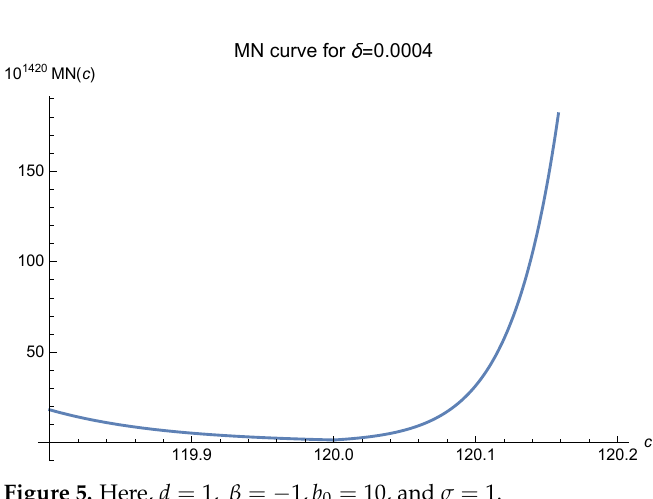
Figure 5. Here, d = 1, β = − 1, b 0 = 10, and σ = 1.